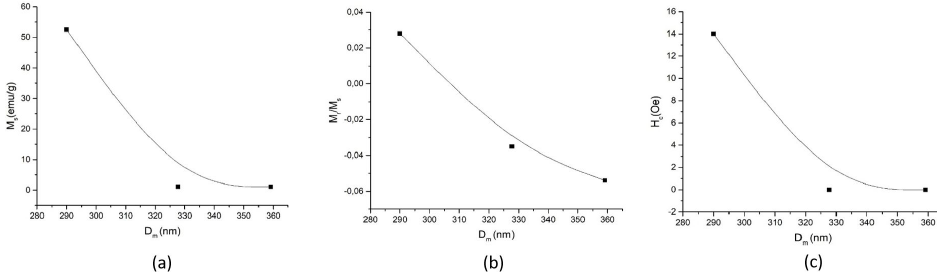
O with its (a) magnetic saturation, (b) remanence ratio, and (c) 2 4